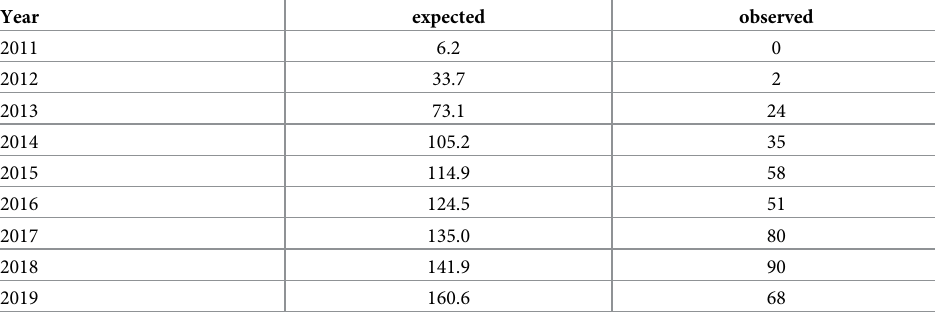
Table 2. Absolute incidence of expected and observed deaths according to calender year.